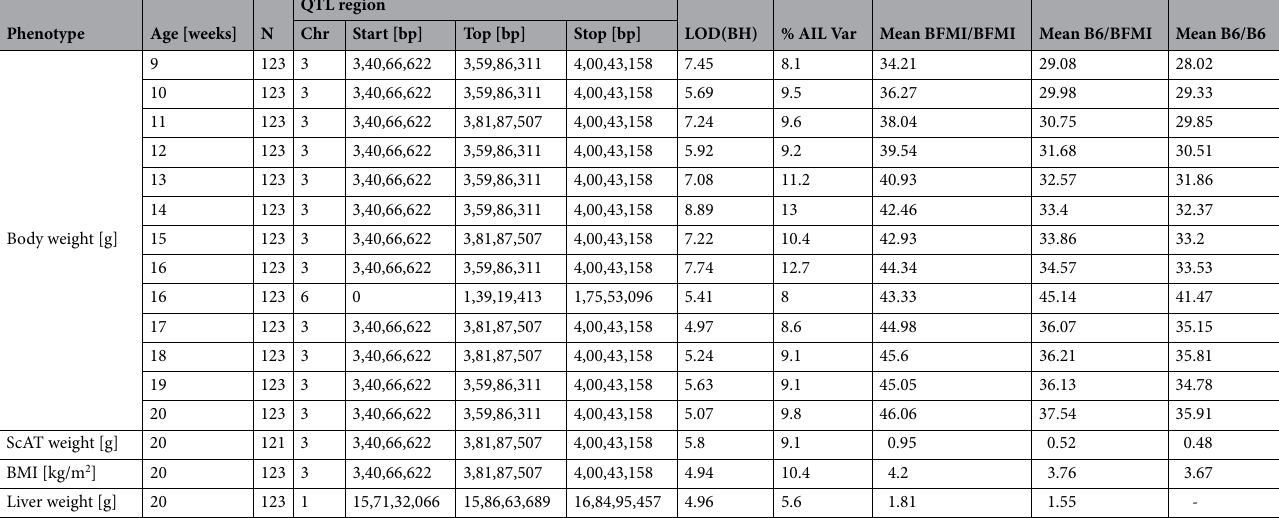
Table 3. QTLs identified for different phenotypes in the AIL BFMI861-S1xB6N population. ScAT, subcutaneous adipose tissue; BMI, body mass index; QTL, quantitative phenotypes locus; Chr, chromosome number; Start, Top, and Stop, position of the start of the QTL confidence interval, position of the SNP with the highest LOD score, and position of the end of the QTL confidence interval in base pairs, respectively. Positions are given according to the Mouse Genome Version MM10, GRCm38.p6. SNP, single-nucleotide polymorphism. The confidence interval gives the 1.5 LOD drop region of the top SNP position. A LOD score above 5.1 was deemed to be ‘genome-wide highly significant’ and above 4.4 was deemed ‘genome- wide significant’. BH, Bonferroni correction; LOD, logarithm (base 10) of odds; Var %, percentage of total variance in AIL explained. The Mean columns show the phenotypic mean adjusted for significant covariates of homozygous BFMI861-S1, heterozygous, and homozygous B6N animals, respectively.